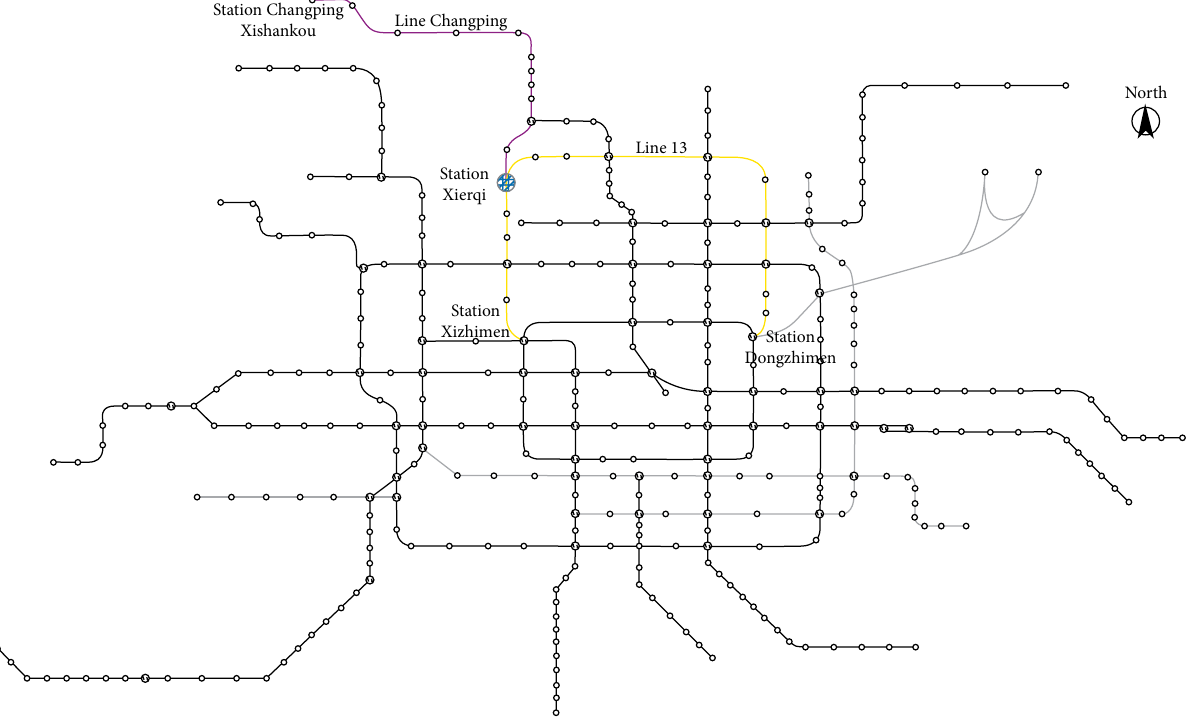
Figure 5: The map of Beijing